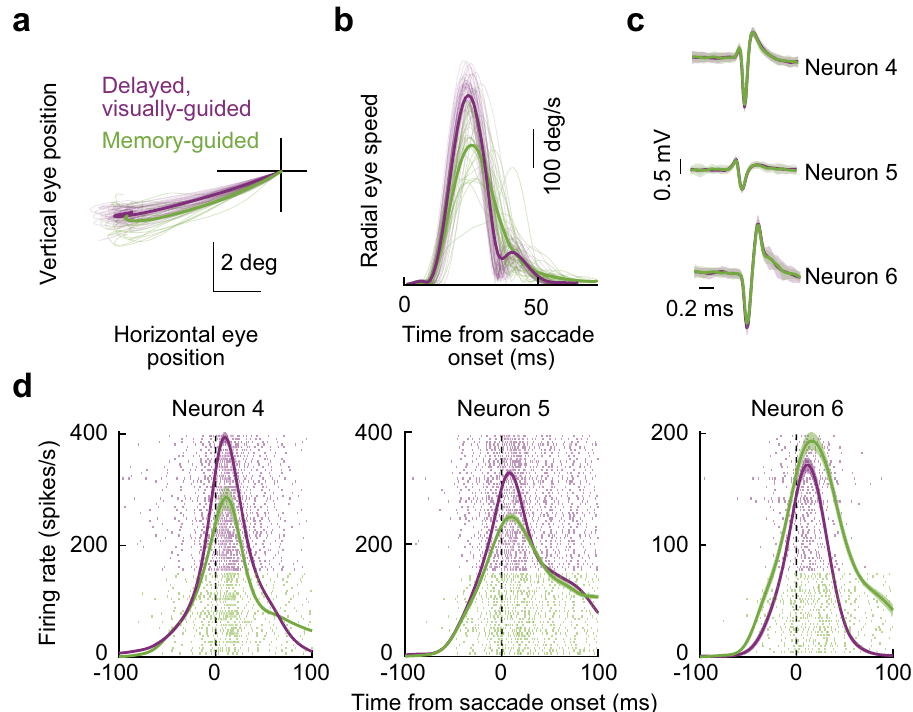
Fig. 7 Similar observations from another example SC site. The fi gure is formatted identically to Fig. 6. The site of this example session was now in the SC ’ s lower visual fi eld representation, as evidenced by the downward oblique saccades in ( a ). Note how the saccade speed was clearly different between visually-guided and memory-guided saccades ( b ), but the neurons still had a diversity of effects in terms of motor burst strengths ( d ). The numbers of spike waveforms included in the averages of c for the visually-guided and memory-guided conditions, respectively, are: 117/82 (Neuron 4), 76/65 (Neuron 5), and 85/81 (Neuron 6). Error bars in c denote s.d., and error bars in d denote s.e.m.